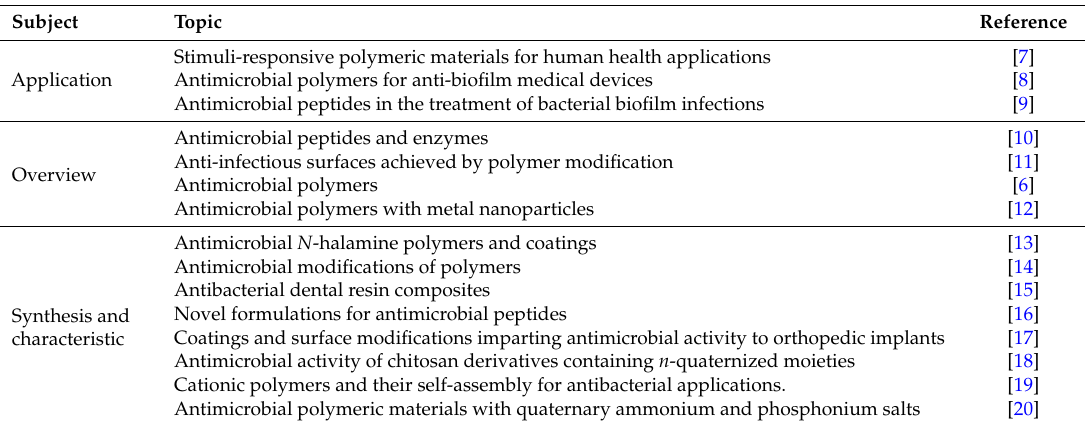
Table 1. Recent review articles of antimicrobial